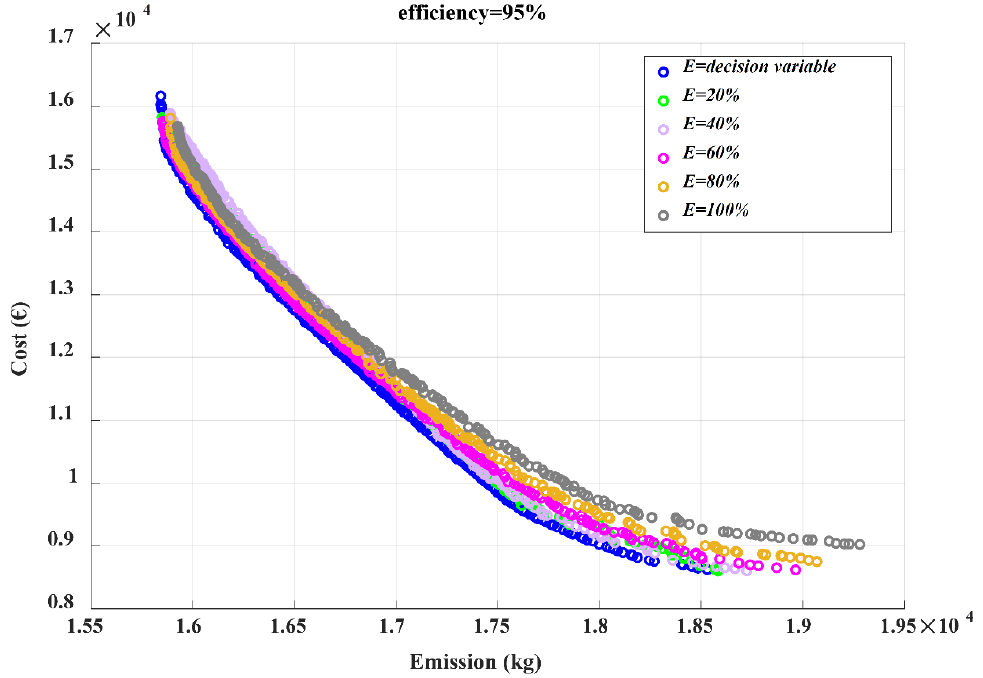
Figure 12. Comparison of Pareto optimal fronts for different E values (95% efficiency).